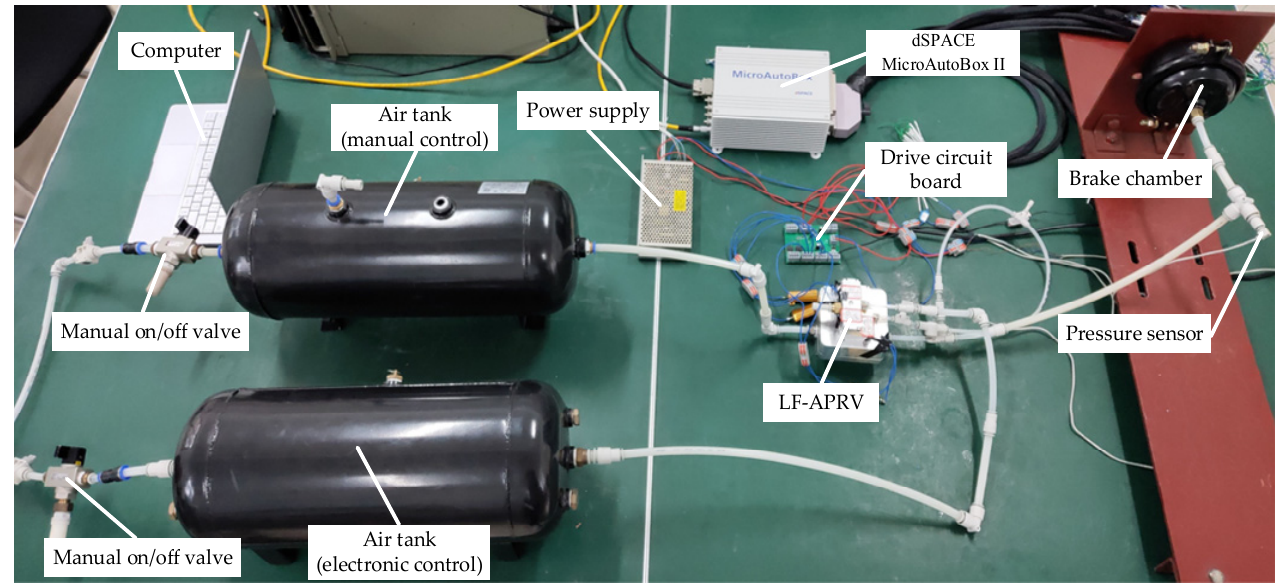
Figure 7. Performance test system of dynamic PWM coupling pressure regulation method of the LF-APRV.